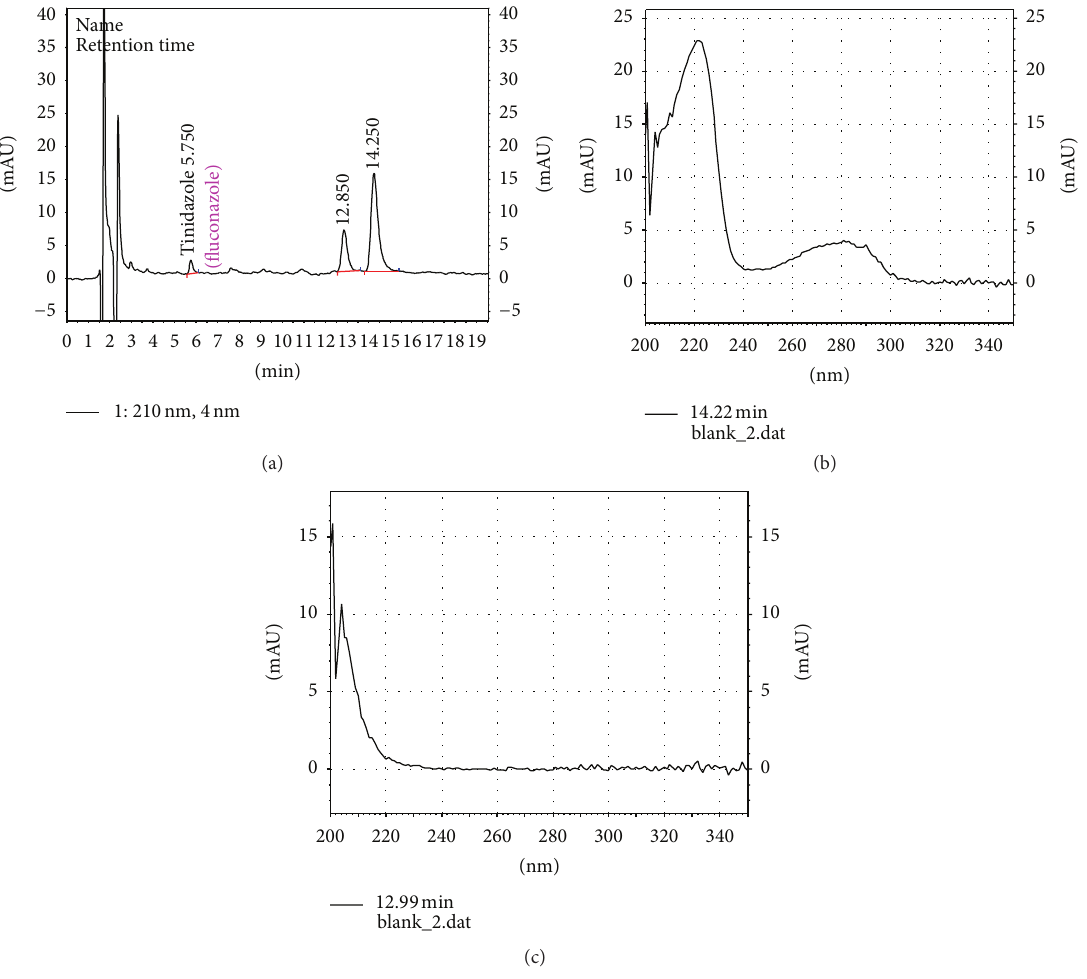
Figure 3: Typical chromatogram of fungi biomass blank with IS tinidazole (a). UV spectra of peak with RT at approximately 13 min (b) and UV spectra of peak with RT at approximately 15min